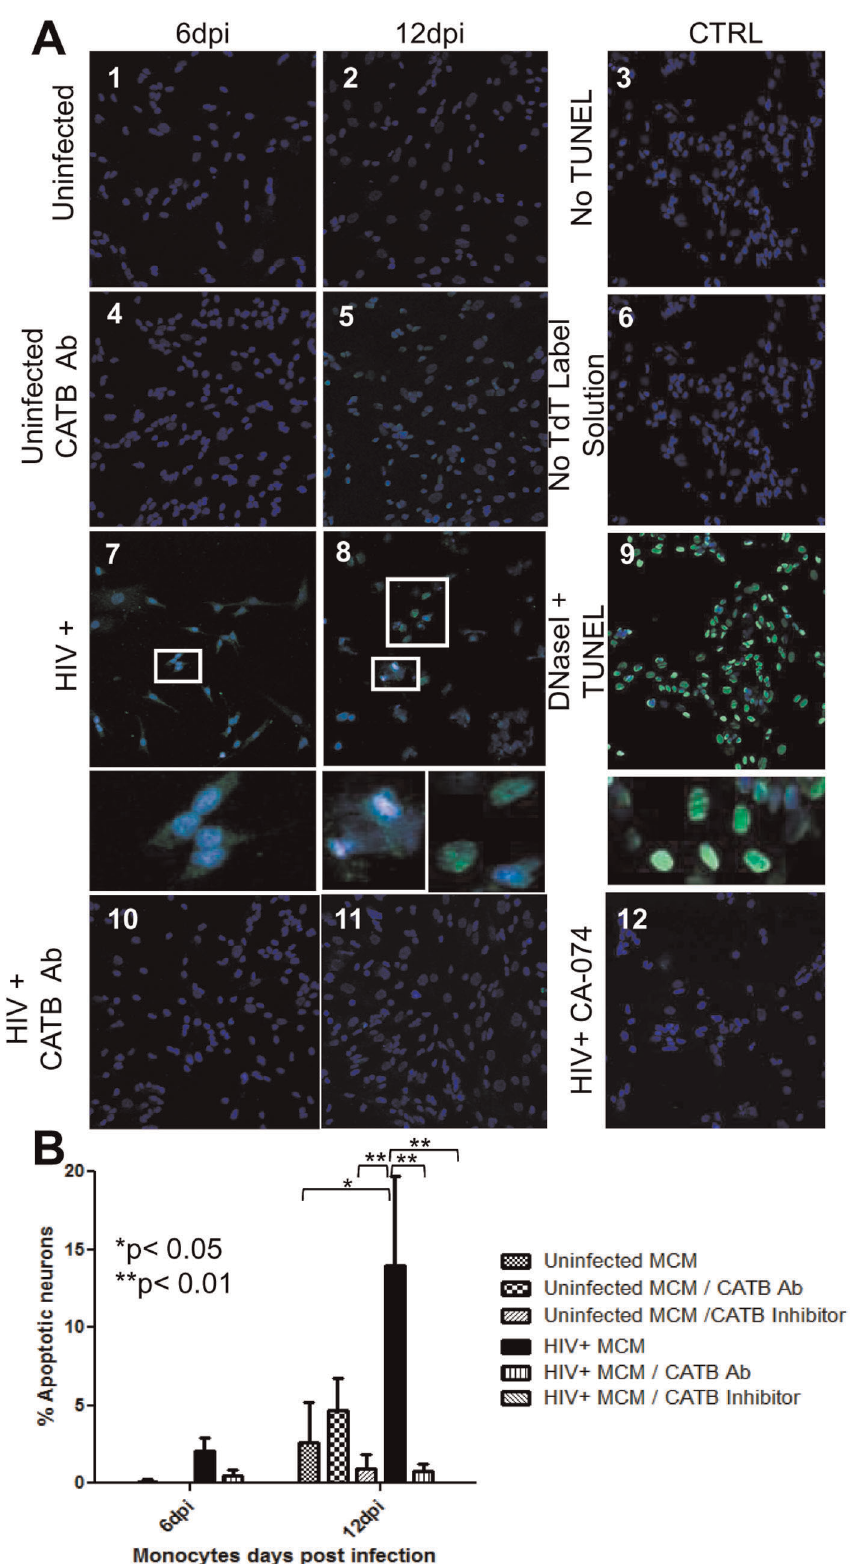
Figure 4. Cathepsin B contributes to neuronal apoptosis caused by HIV-infected MDM. Apoptosis was measured using terminal deoxynucleotidyl transferase dUTP nick end labeling (TUNEL) assay at 6 and 12 days post-infection as shown by green fluorescence in neurons stained with DAPI (blue) (Panel A). These results in panel A are representative of four experiments. The SK-N-SH cells exposed to MCM from uninfected MDM (1–2) with the cathepsin B antibody (3–4) do not show apoptosis. Neuronal apoptosis increased after exposure to HIV infected MCM